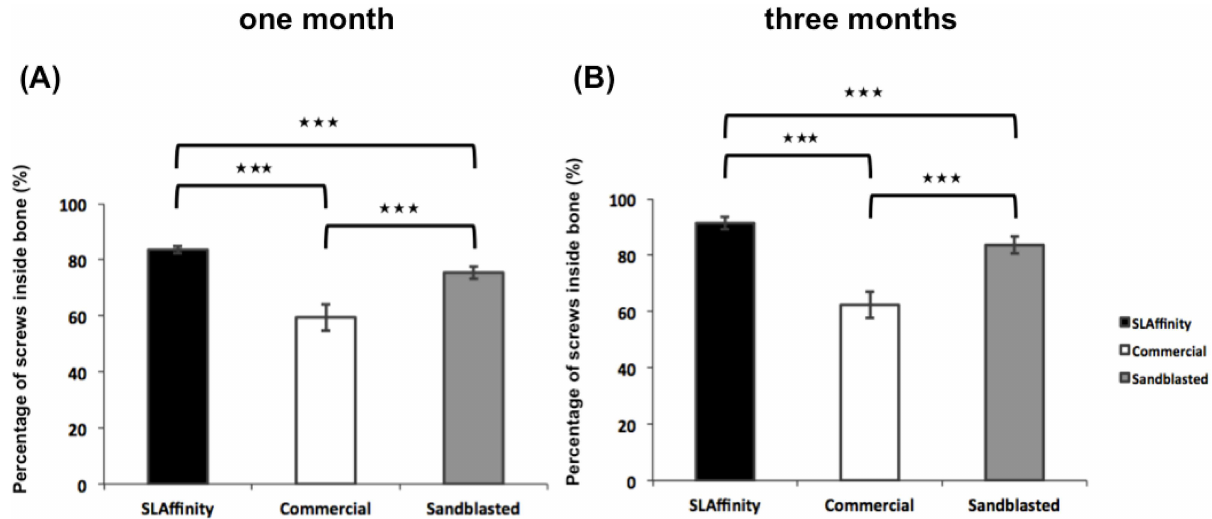
Fig 7. The percentage of different pedicle screws inside vertebralcolumn after implantation. (A) 1 month and (B) 3 months after implantation. *** : p < 0.001.